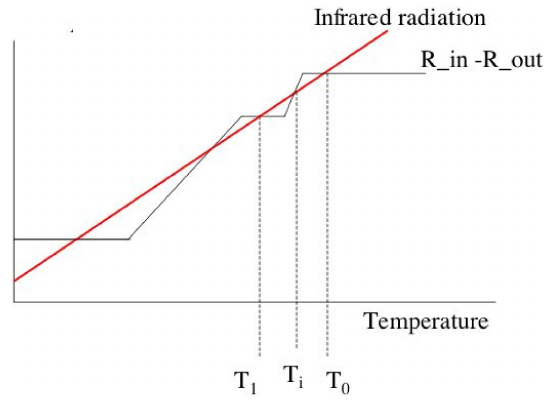
Fig. 2. The albedo feedback for an energy balance model with three climate states near T 0 . The model is conceptually similar to the one described in Fig. 1 with a change in the